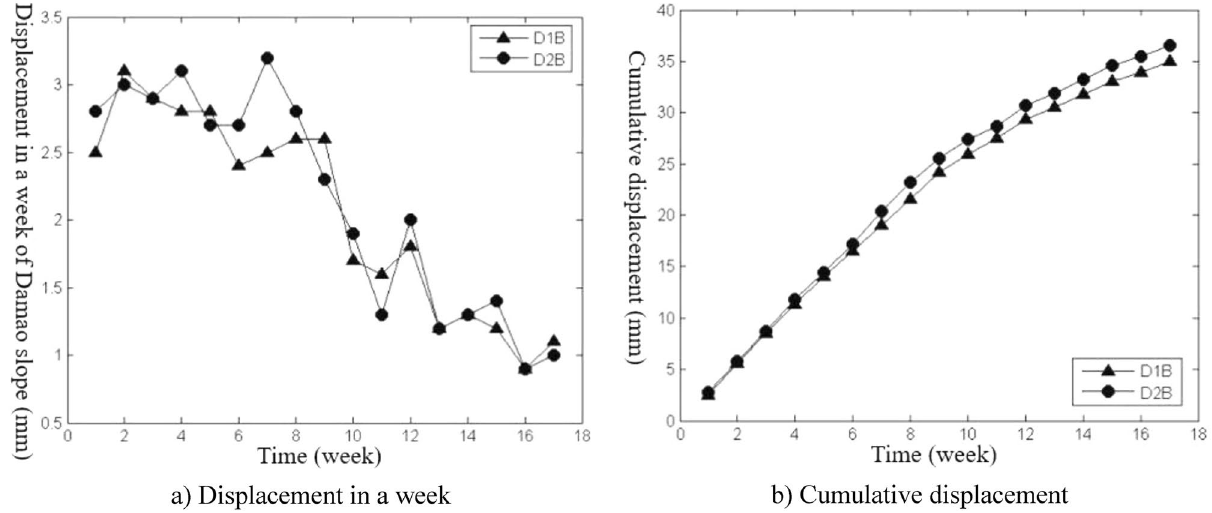
Figure 4. Displacement curves of monitoring points on the slope top from July 26 to November 15.